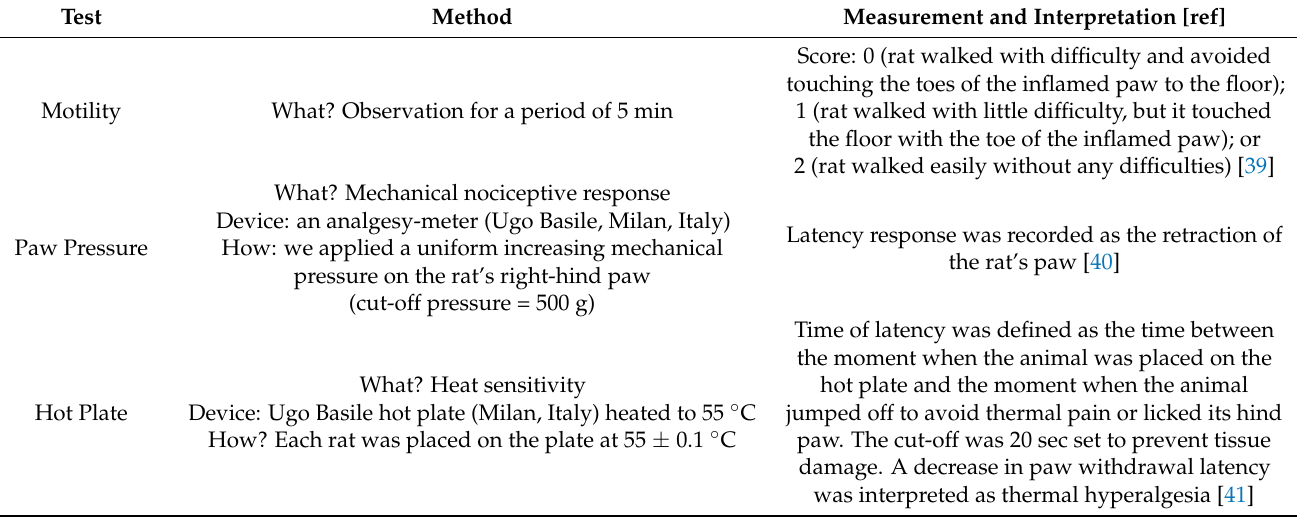
Table 2. Description of applied test, measurements and